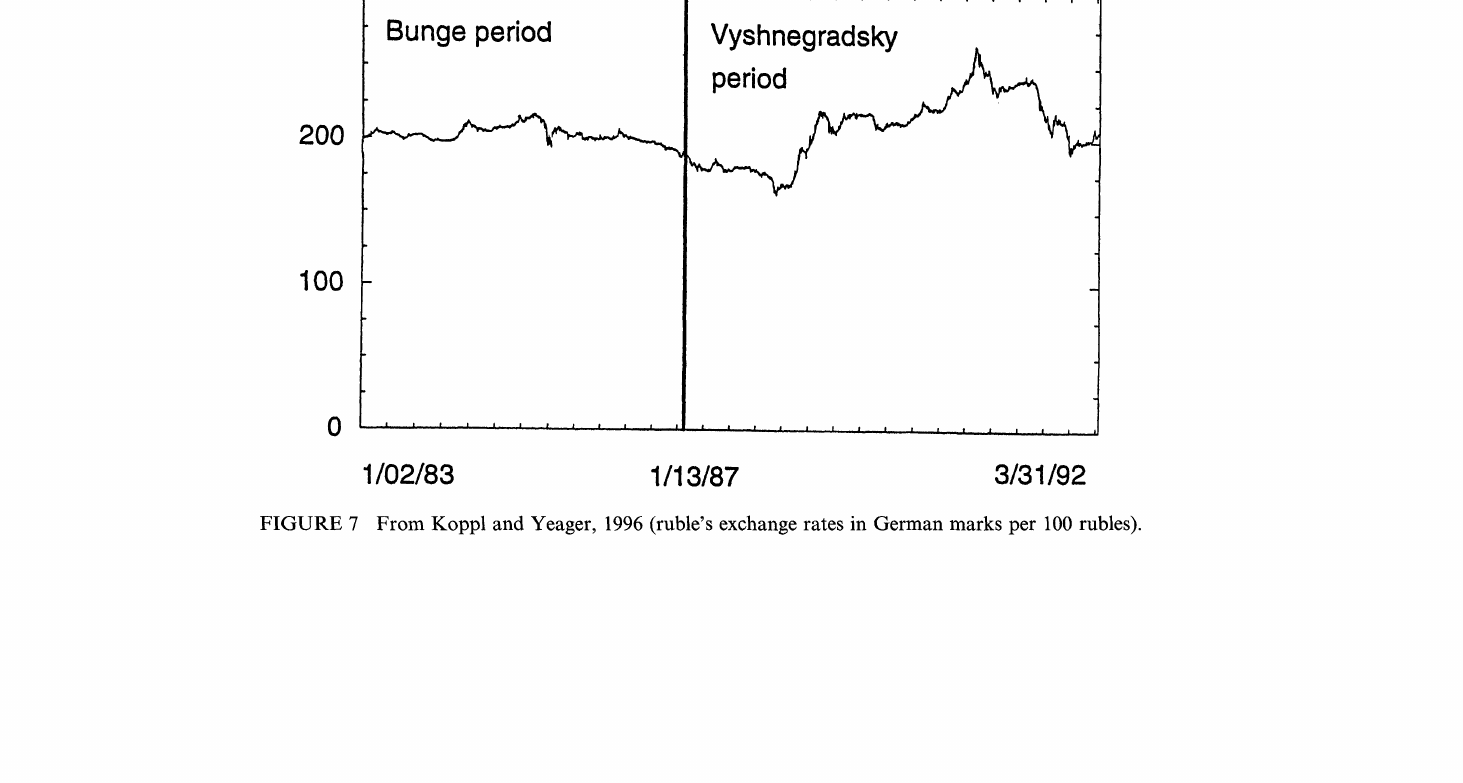
FIGURE 7 From Koppl and Yeager, 1996 (ruble’s exchange rates in German marks per 100